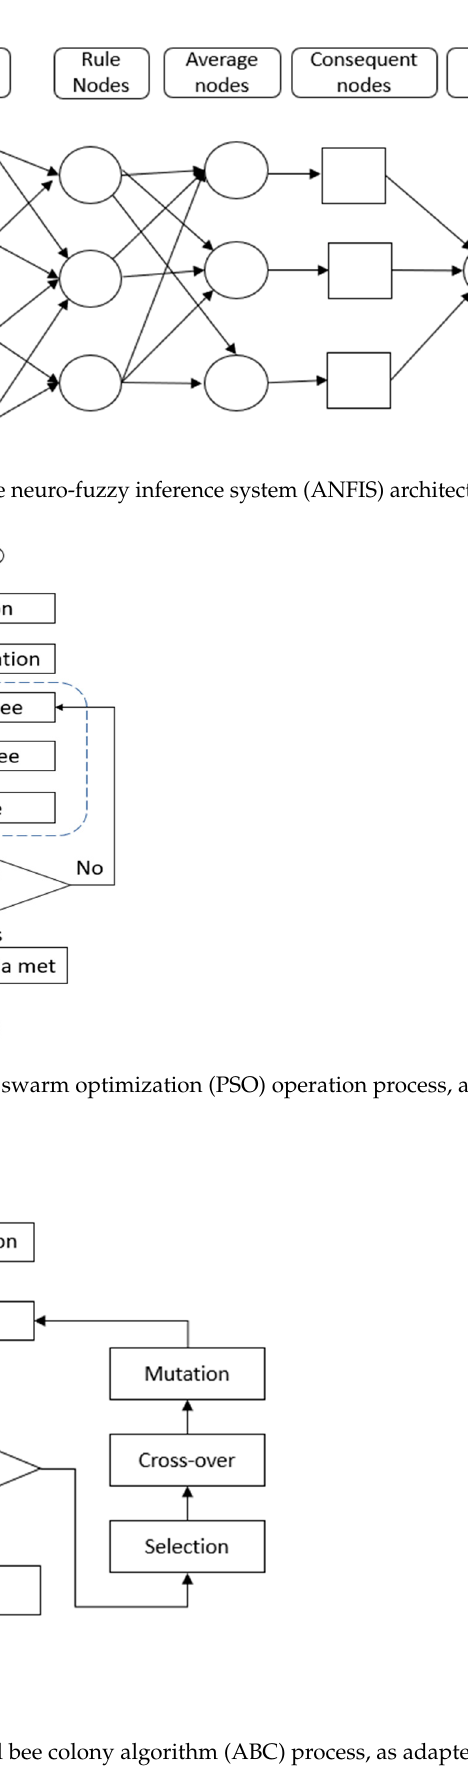
Figure 4. The genetic algorithm process, as adapted from Ref. [40]. Particle swarm optimization (PSO) is an evolutionary method of computation based on the simulation of simple models. The advantages include requiring a smaller memory, higher computational speeds, and easier management. Figure 2 illustrates the PSO oper- ation process. Artificial bee colony (ABC) is a revolutionary optimization algorithm. It can be de- fined as a mechanism that occurs from the dynamic interaction between the structure and parts disordered. The flow chart in Figure 3 shows this type of AI. Genetic algorithm (GA) is a population-based optimization algorithm with a percent- age of high reliability. It is a strong optimization algorithm with high performance. This algorithm is always adopted as a strong tool in the AM optimization process. The flow chart in Figure 4 shows the GA process.